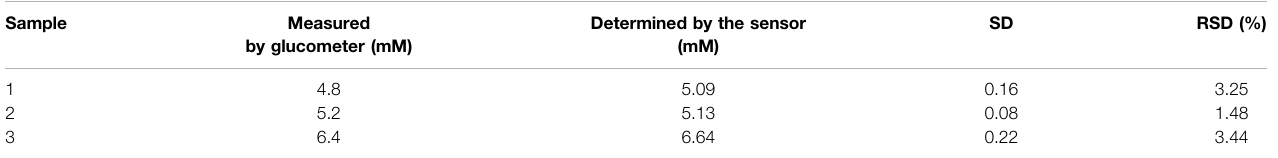
TABLE 1 | Sensor in this study and the blood glucose meter test on serum samples (n (cid:1) 3). Sample